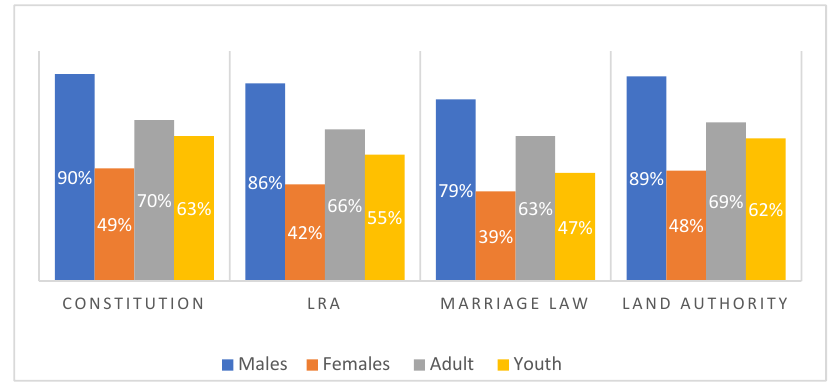
Figure 1. Community members’ awareness of of land laws/institutions, by gender/age.